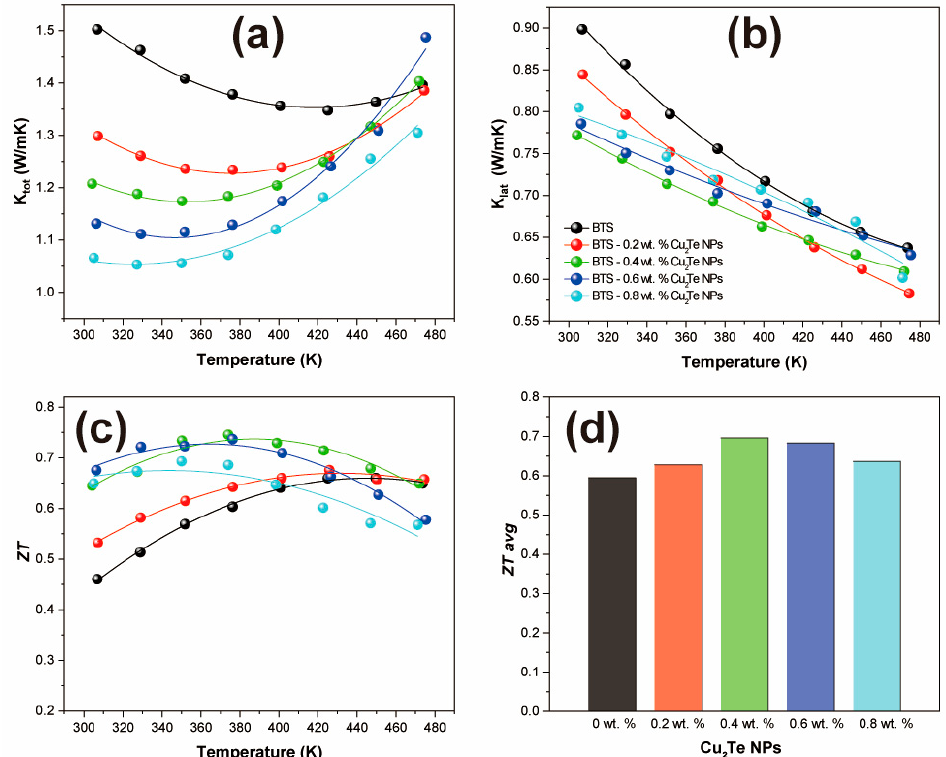
Figure 3. ( a ) Total thermal conductivities, ( b ) lattice thermal conductivities, ( c ) ZT values, and ( d ) average ZT values between room temperature and 470 K of BTS ‐ x wt.% Cu 2 Te NPs ( x = 0, 0.2, 0.4, 0.6, and 0.8).